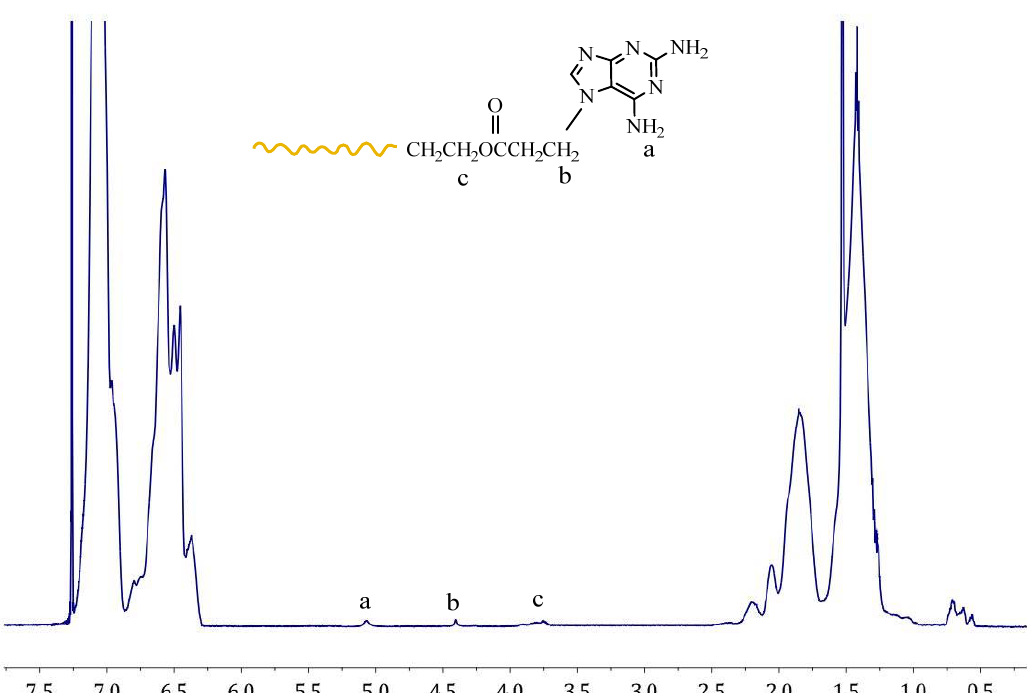
Figure 4. 1 H ‐ NMR spectrum of sample PS ‐ b ‐ PI ‐ Thy.